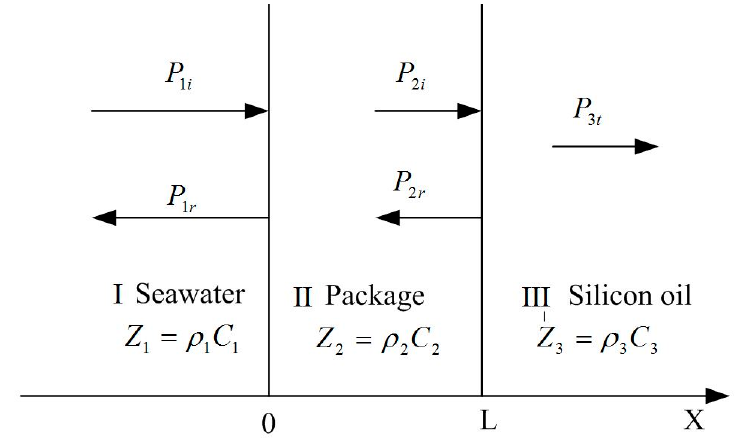
Figure 13. Theoretical model of three layer medium. Table 6. Acoustic impedance of common material.